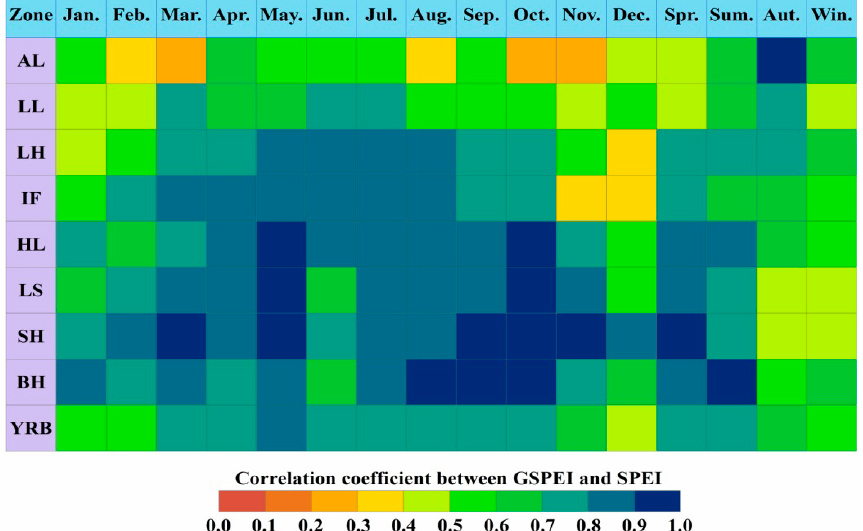
Figure 5. Correlation coefficient (CC) between Gridded Standardized Precipitation Evapotranspiration Index (GSPEI) and Standardized Precipitation Evapotranspiration Index (SPEI).